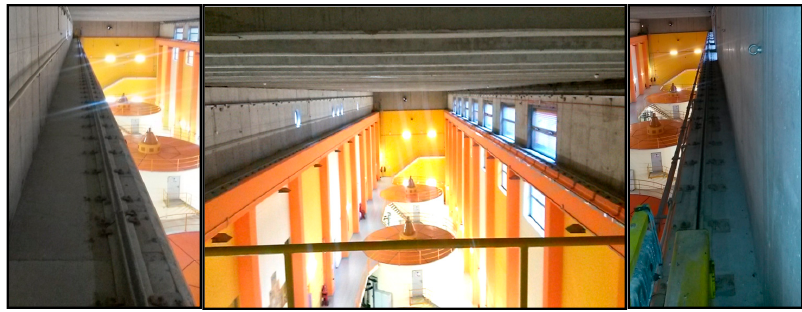
Figure 3. Crane rails in the machine room in the hydroelectric power plant (HPP) in Krško.